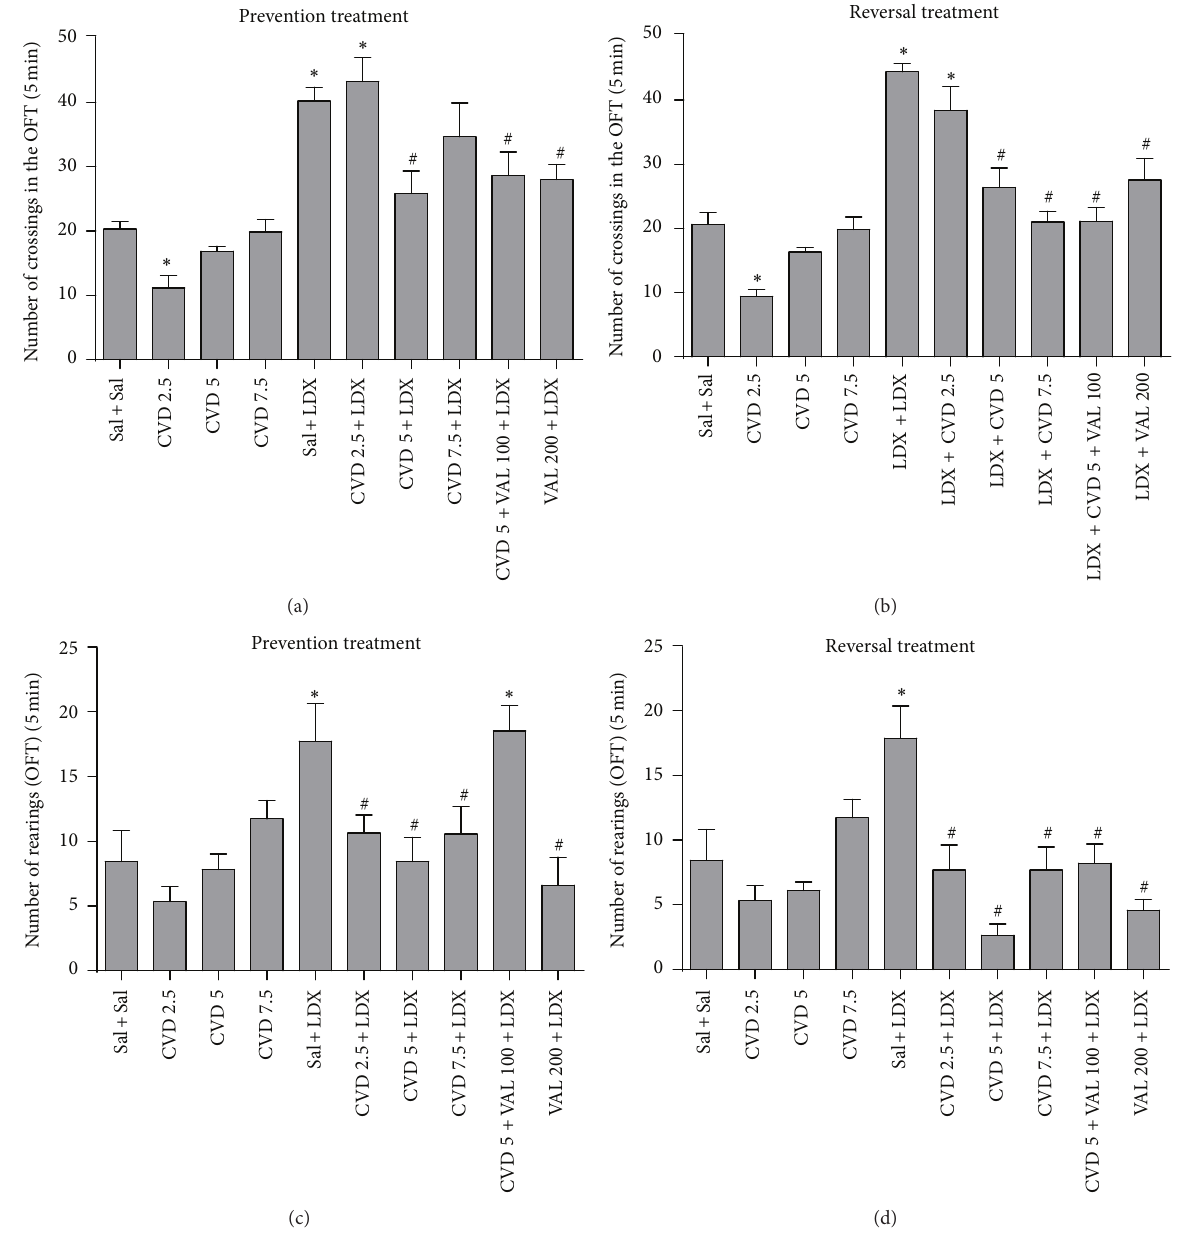
Figure 2: Number of crossings and rearings in the open field test in animals submitted to the prevention ((a), (c)) and reversal ((b), (d)) treatments. Data were analyzed by one-way ANOVA followed by Student-Newman-Keuls post hoc test. Values represent mean ± SEM (6–8 animals/group). ∗ 𝑃 < 0.05 versus Sal + Sal; # 𝑃 < 0.05 versus Sal + LDX or LDX + LDX. CVD: carvedilol; LDX: lisdexamfetamine; OFT: open field test; Sal: saline; VAL: